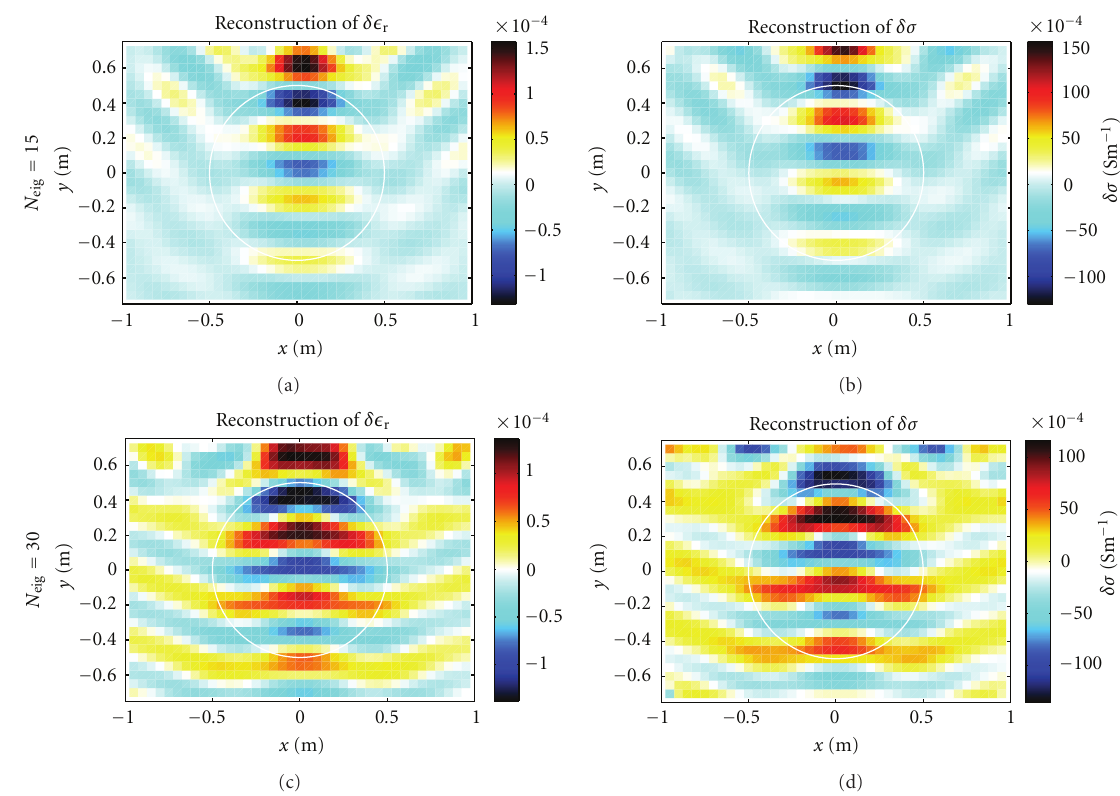
Figure 3: Reconstruction of δ (cid:2) r and δσ in a maximum likelihood-based data fusion where the statistically-based weighting is R (2) /R (1) = 92. The upper and lower rows are obtained by using N eig = 15 and N eig = 30 eigenvalues,